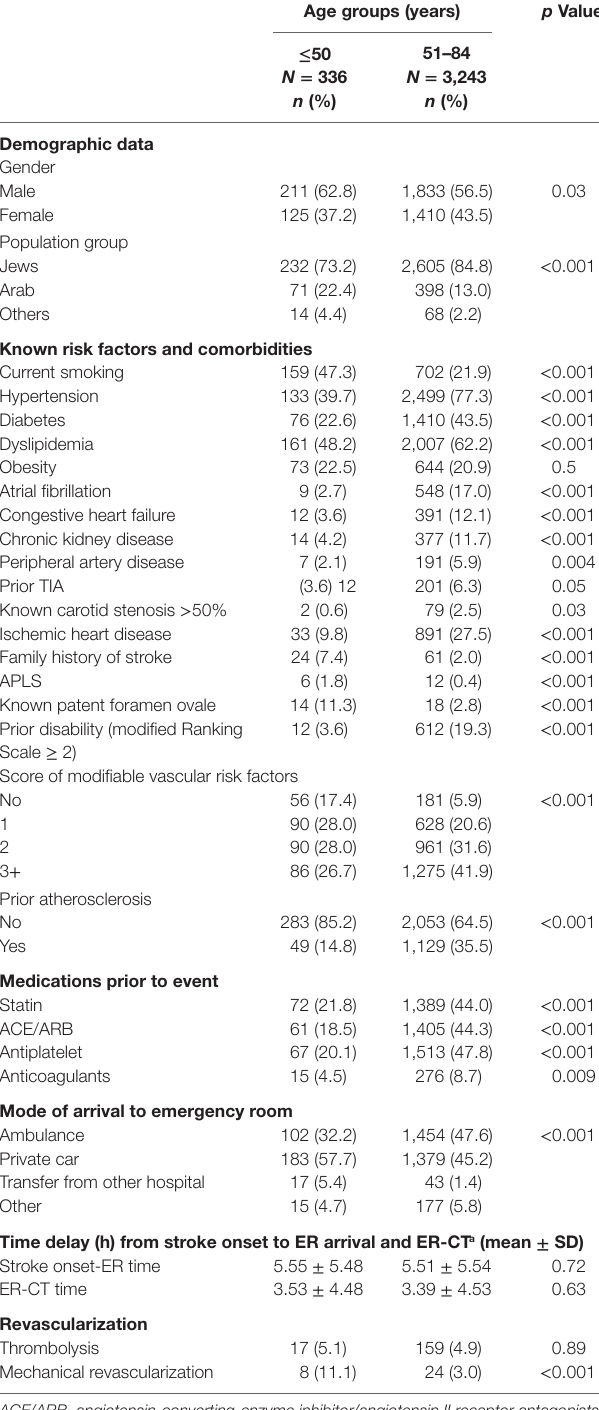
TaBle 1 | Characteristics and health-related conditions of stroke patients, by age